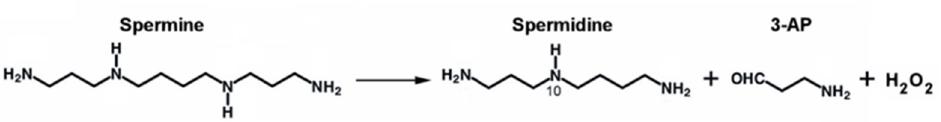
Figure 3. Spermine oxidase enzymatic reaction. The substrate spermine is oxidized to produce spermidine, 3-aminopropanal (3-AP), and hydrogen peroxide (H 2 O 2 ). The SMOX enzyme is expressed in various tissues, mainly in brain and skeletal muscle, and regulates the Spm/Spd ratio to keep the cellular PA content balanced [7,15].